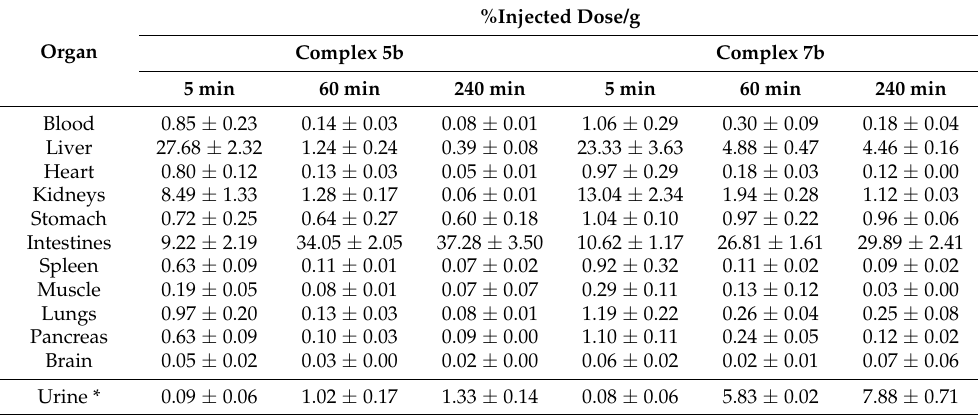
Table 4. Biodistribution data after intravenous injection of fac -[ 99m Tc(NNO)(CO) 3 ] ( 5b ) and fac - [ 99m Tc(NNO)(CO) 3 ] ( 7b ) in healthy mice at 5, 60, and 240 min.